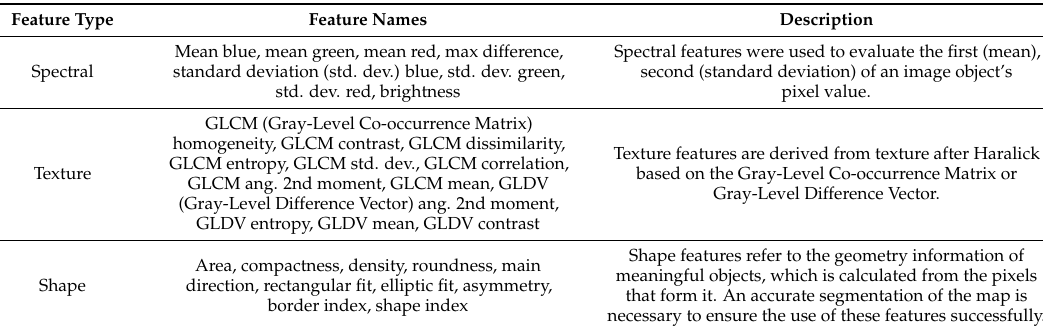
Table 1. List of object